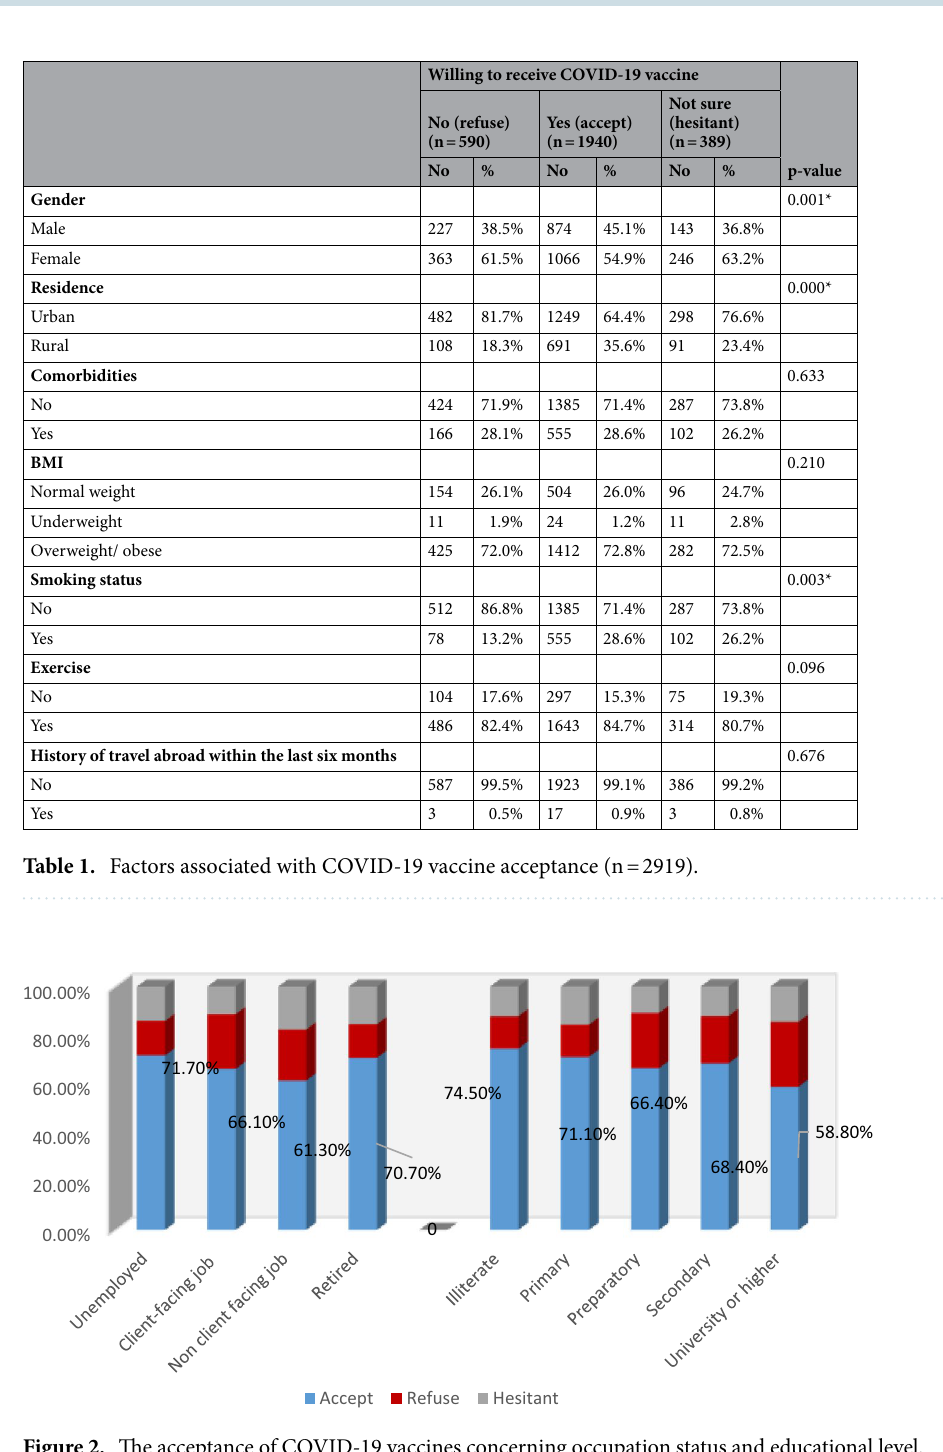
Figure 2. The acceptance of COVID-19 vaccines concerning occupation status and educational